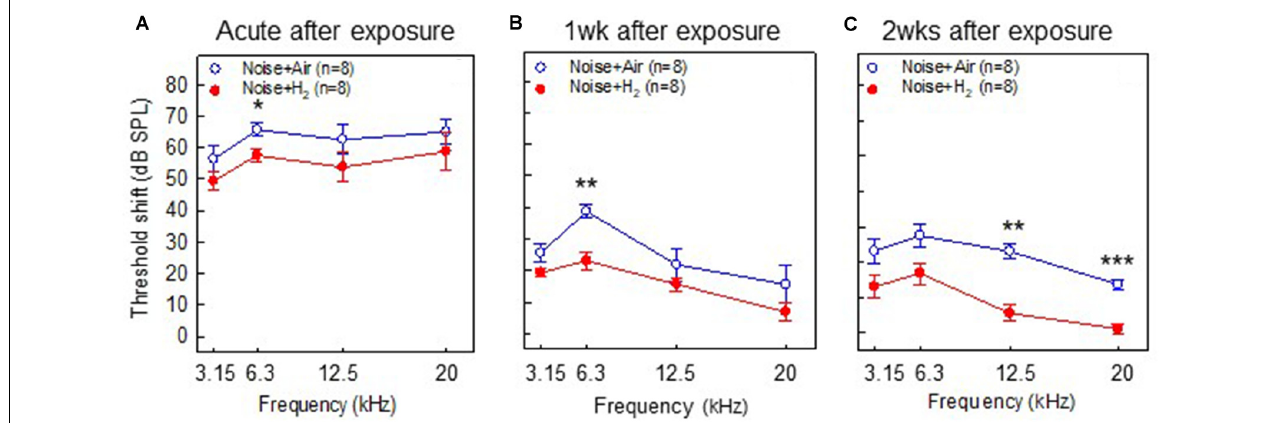
FIGURE 2 | Results from the auditory brainstem response (ABR) measurements performed in (A) group Acute + H 2 and group Acute + Air immediately after inhalation, (B) group 1w + H 2 and 1w + Air 1 week, and (C) group 2w + H 2 and 2w + Air 2 weeks after noise exposure and inhalation of H 2 or air. The y-axis shows the mean threshold shift as compared to the pretreatment values. Data are presented as mean ± SEM. * p < 0.05, ** p < 0.01 and ∗∗∗ p < 0.001.